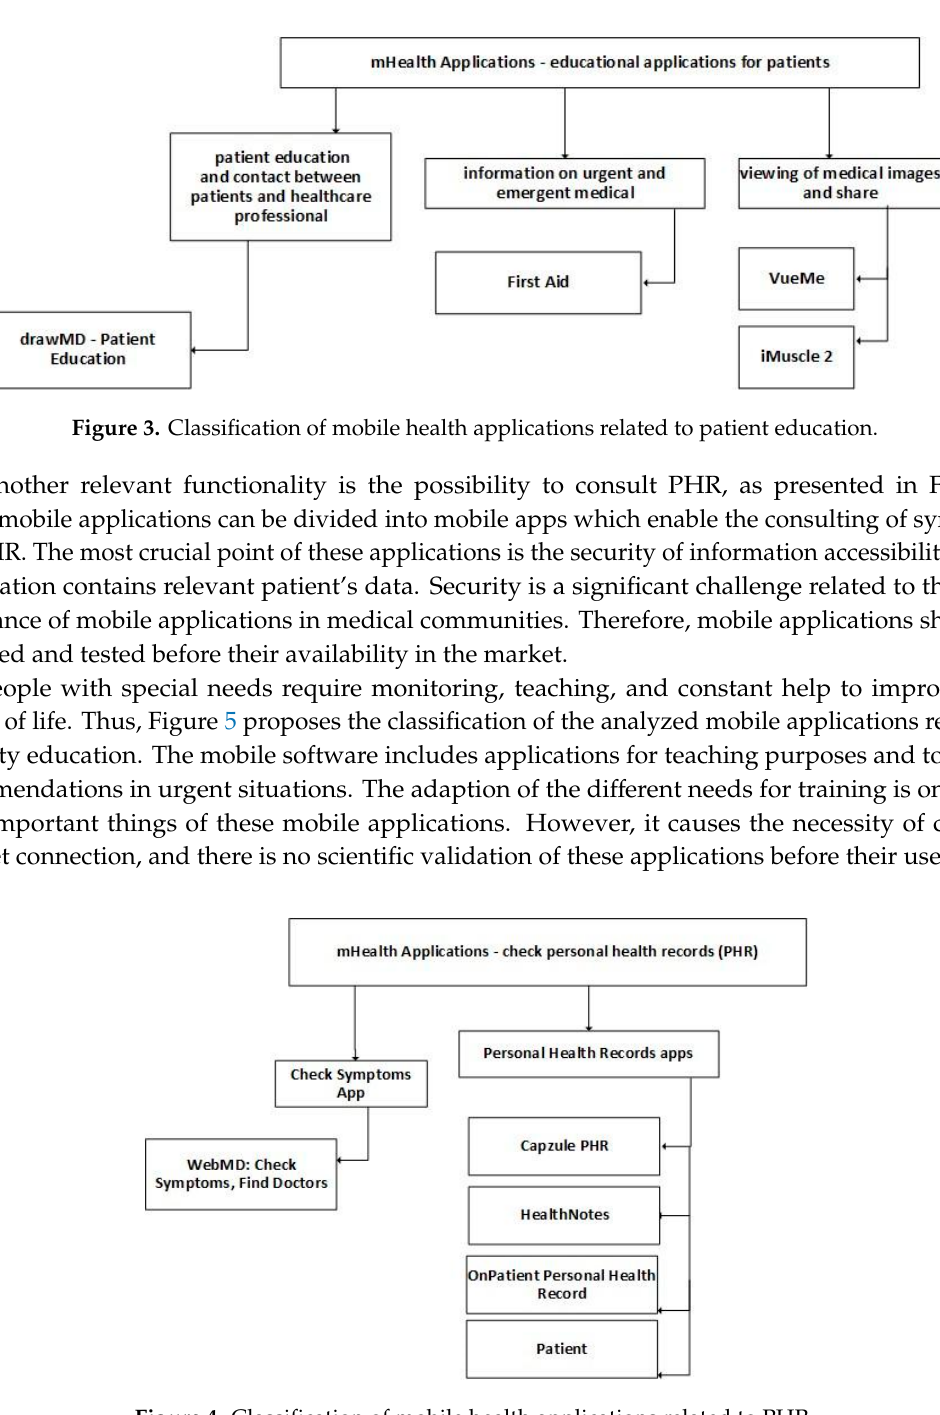
Figure 4. Classification of mobile health applications related to PHR.